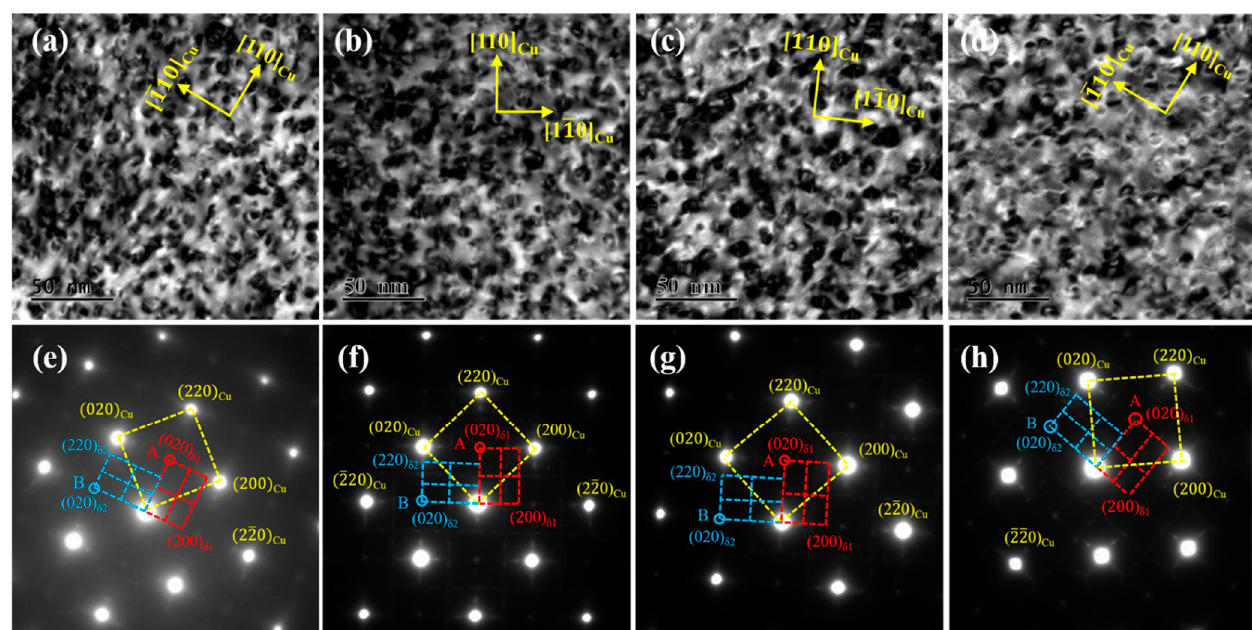
Figure 4. TEM images of the tested alloys at the peak aging state. ( a – d ) Bright-field of [001] Cu ; ( e – h ) SAED of [001] Cu ; ( a , e ) NC-1 alloy; ( b , f ) NC-2 alloy; ( c , g ) NC-3 alloy; ( d , h ) NC-4 alloy.